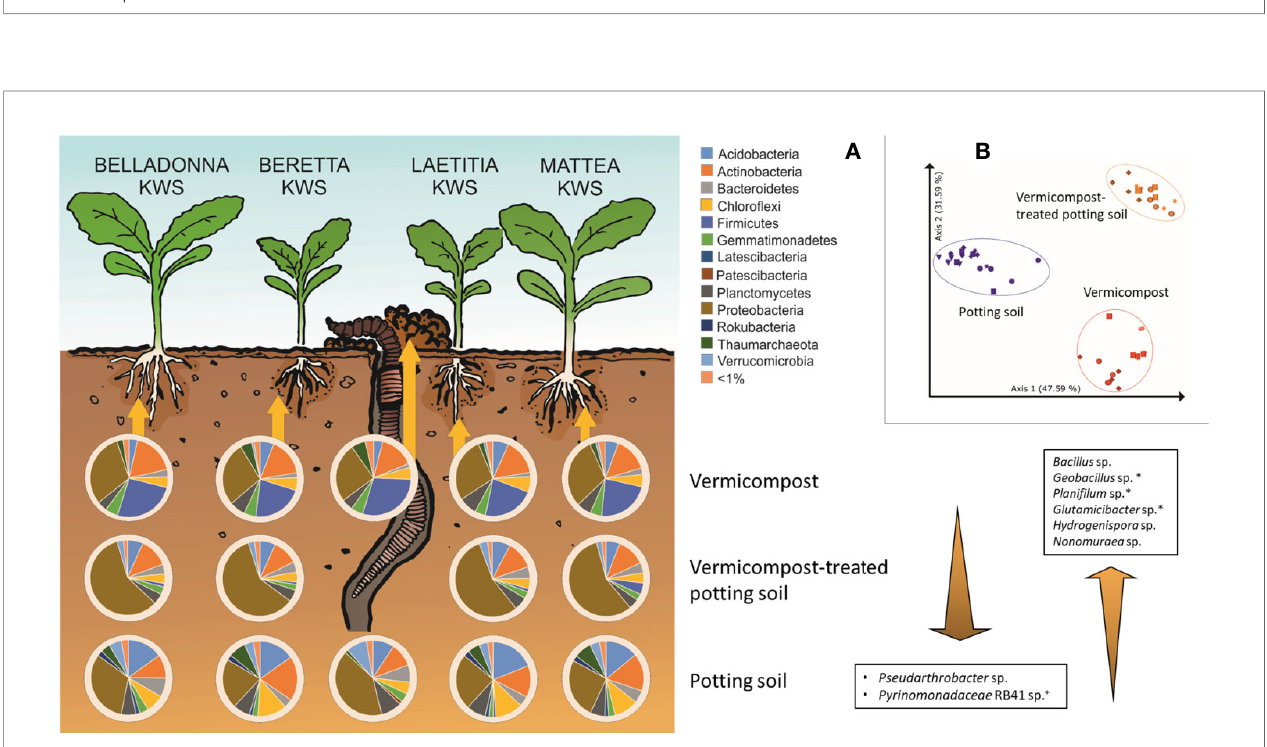
FIGURE 6 | In fl uence of different substrates on bacterial root communities in sugar beet. (A) Composition of bacterial root communities in different substrates on phylum level. Bacterial genera displayed that are signi fi cantly different (Bonferroni-corrected p < 0.05) between substrates, have >1% mean relative abundance and have intermediate abundance in VC-PS samples. + : unique for potting soil; *: unique for vermicompost; PS: potting soil; VC-PS: vermicompost-treated potting soil; VC: vermicompost. (B) PCoA-plot of Bray-Curtis dissimilarities of root samples grown in different substrates, only samples with seed origin from Italy; spheres: cv. BELLADONNA; diamonds: cv. BERETTA; squares: cv. LAETITIA; stars: cv.